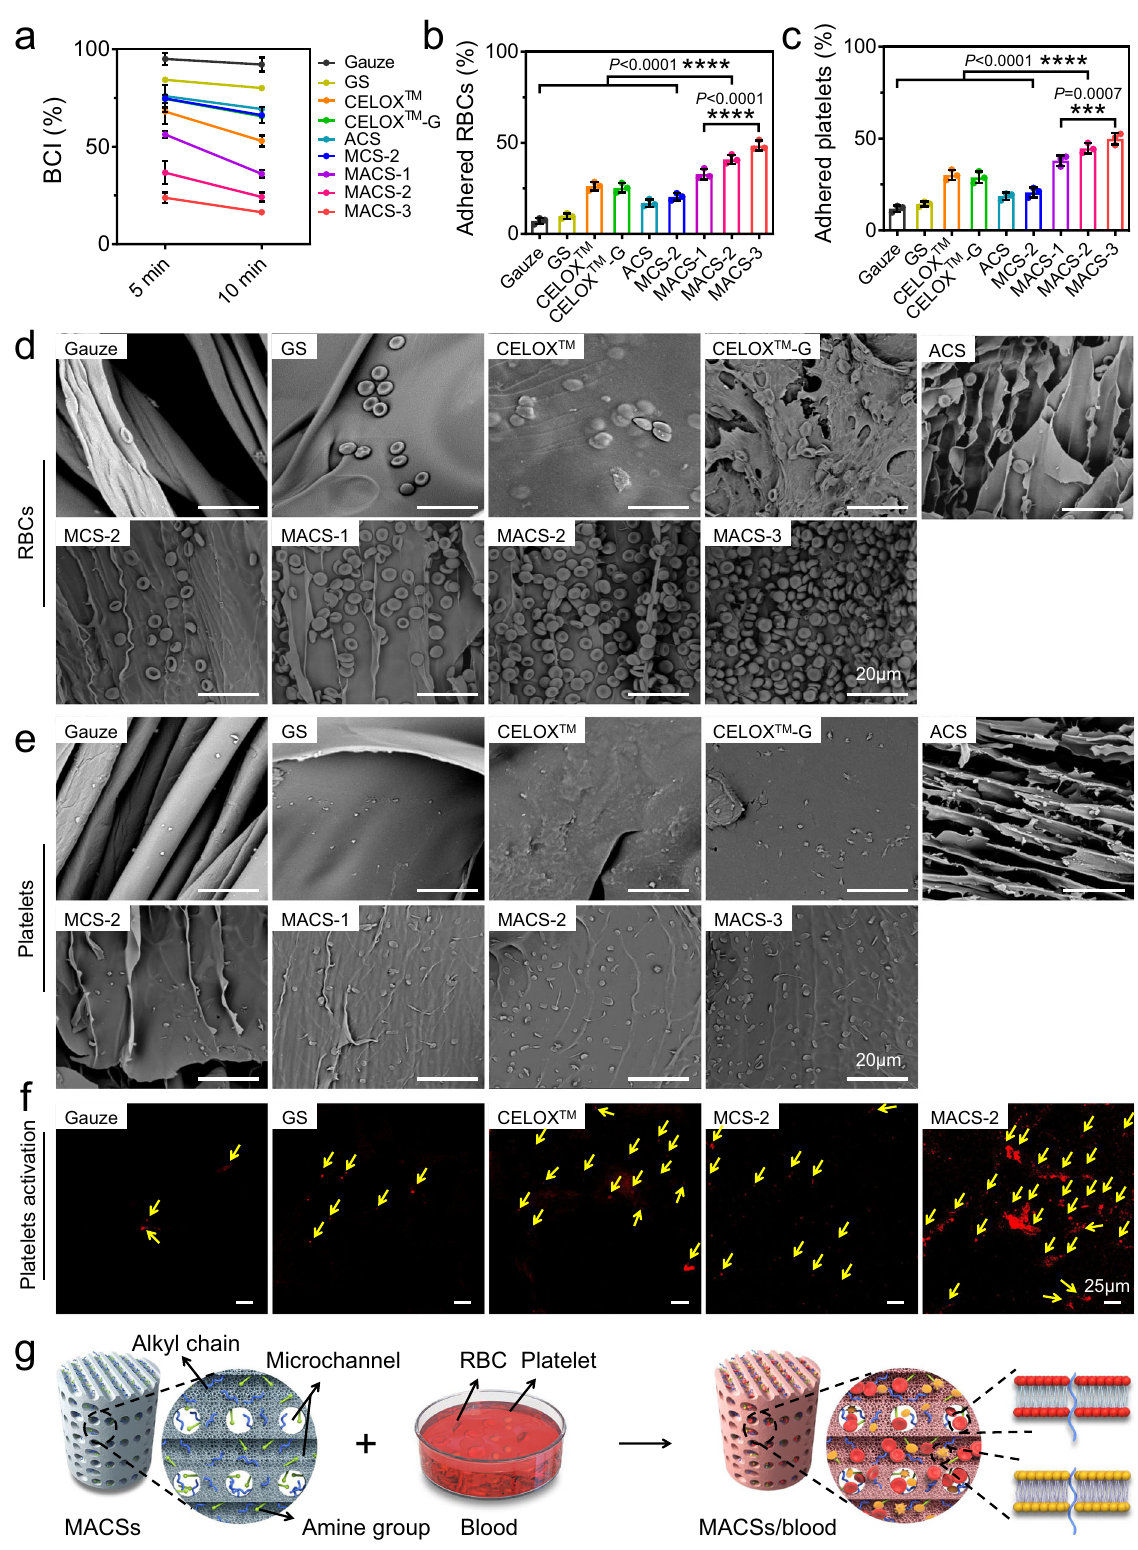
Fig. 5 The pro-coagulant ability of the gauze, GS, CELOX TM , CELOX TM -G, ACS, MCS-2, and MACSs. a The BCI-time curves of various samples. b , c The percentage of adhered RBCs and platelets on various samples. n = 3 independent samples. Data are expressed as mean ± SD. The signi fi cant difference was detected by one-way ANOVA with Tukey ’ s multiple comparisons test. The ‘ ns ’ indicated no signi fi cant difference, *P < 0.05, **P < 0.01, ***P < 0.001, ****P < 0.0001. d , e SEM images showing adhesion of RBCs and platelets on various samples. f Immuno fl uorescence staining of CD62p showing the activation of platelets on various samples. The yellow arrow represented activated platelet. g Schematic diagram illustrating the pro-coagulant mechanism of the MACSs. BCI: blood clotting index; RBCs: red blood